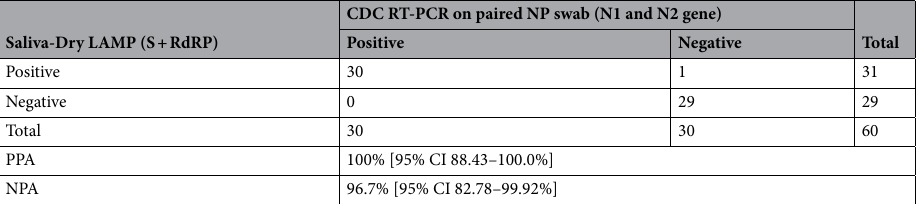
Saliva-Dry LAMP (S + RdRP)